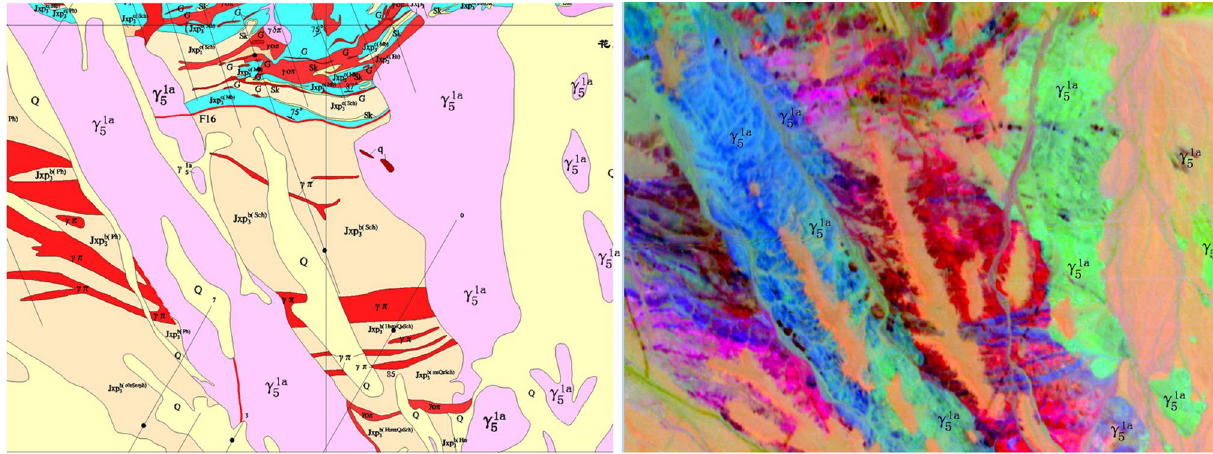
Figure 5. Mineral geological map on the left, composite image of the 2nd, 3rd and 14th components of MNF on the right. This figure is generated by Yu-Qing Wan, using ENVI (version4.3) created by the ENVI Team under an open license (http://www.envii